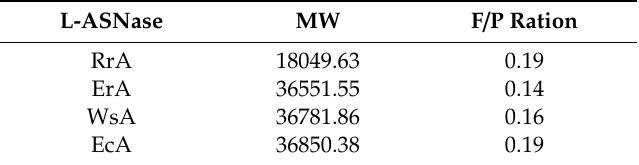
Figure 1. The ability of RrA, but no other L-asparaginases, to suppress telomerase activity. Jurkat cells were incubated with L-ASNases or L-ASNases conjugated with FITC for 12 h. ( A ) Telomerase activity determined by TRAP assay in cells incubated with L-ASNases. ( B ) Results of TRAP quantification by densitometry. ( C ) Levels of hTERT mRNA expression normalized relative to the expression of the reference gene 18S. ( D ) Flow cytometry results for cells incubated with L-ASNases or FITC- conjugated L-ASNases. ( E ) Representative flow cytometry diagrams for incubated cells. ( F ) Mean fluorescence intensity of FITC-positive cells. n = 4. * p ≤ 0.05 vs. control cells treated with non- conjugated L-ASNase. HI, sample with heat-inactivated telomerase.